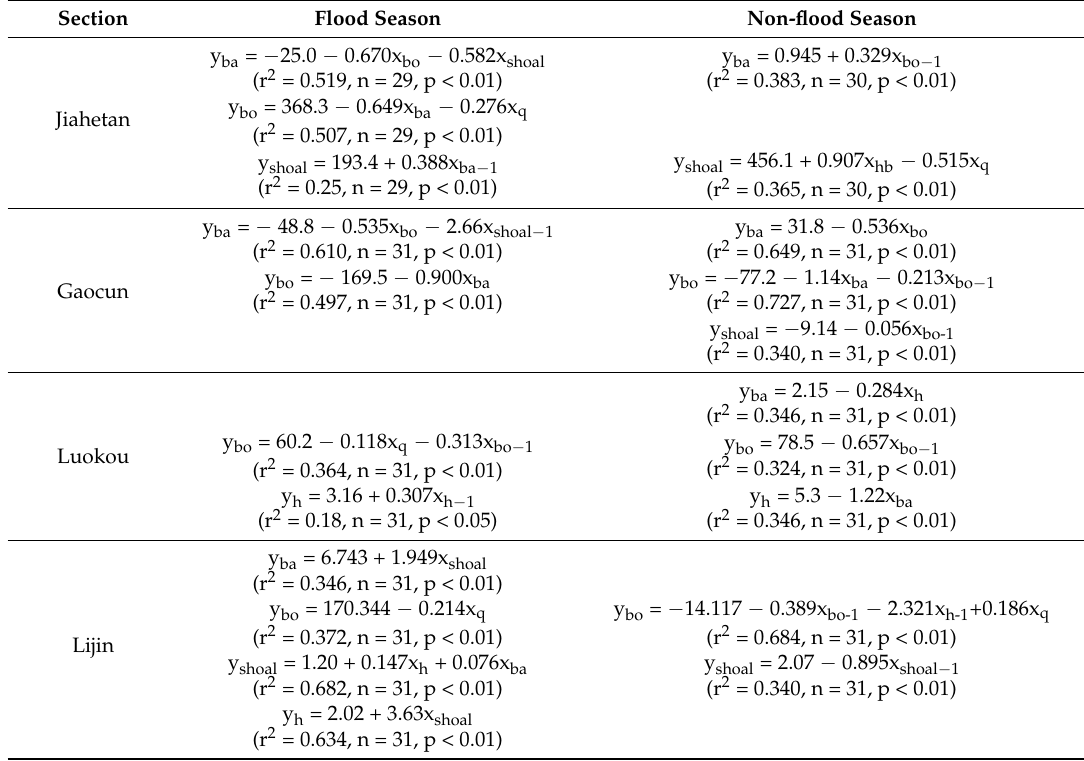
Table 1. Regression relations of erosion/deposition on different geomorphic units in four cross-sections in flood and non-flood seasons with influencing